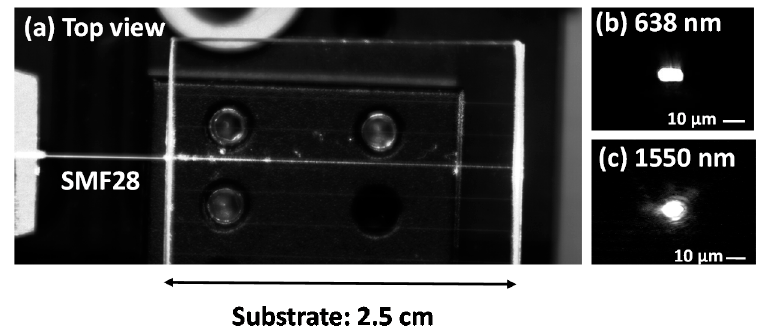
Figure 14. Characterization of TiO 2 –SiO 2 waveguides (surrounded by air). The figure illustrates: ( a ) top-view of the waveguide injection at 638 nm, ( b ) output optical guided mode at 638 nm and ( c ) guided mode at 1550 nm.